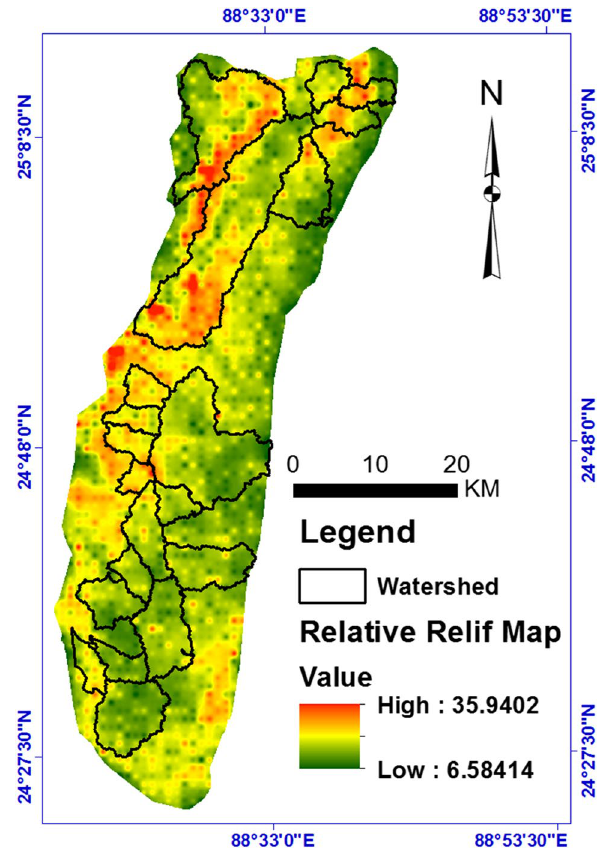
Fig. 9 Relative relief map of the proposed area